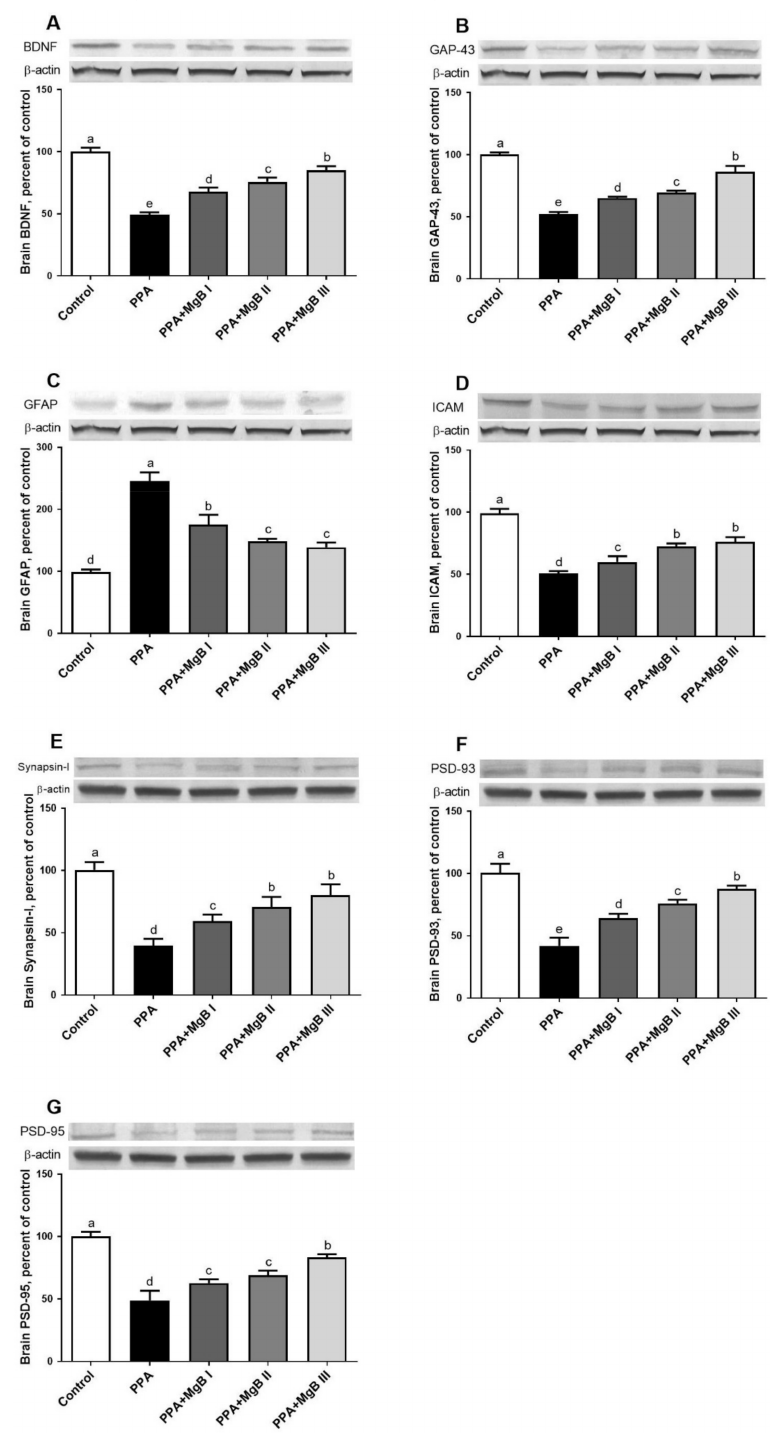
Figure 5. Effects of MgB supplementation on the brain-derived neurotrophic factor (BDNF, ( A )), growth-associated protein (GAP-43, ( B )), glial fibrillary acidic protein (GFAP, ( C )), intercellular adhesion molecule 1 (ICAM, ( D )), Synapsin I ( E ), postsynaptic density protein 93 (PSD-93, ( F )) and postsynaptic density protein 95 (PSD-95, ( G )) protein levels in PPA-induced autism in rats. Blots were repeated at least 3 times. a–e: Values within the bars with different superscripts are significantly different (Tukey’s post-hoc test, p <